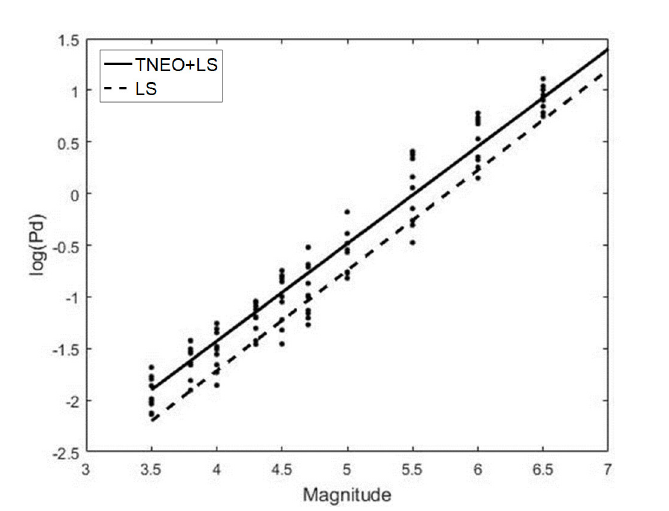
Figure 5. Linear regression model comparison for P d - M g relation.